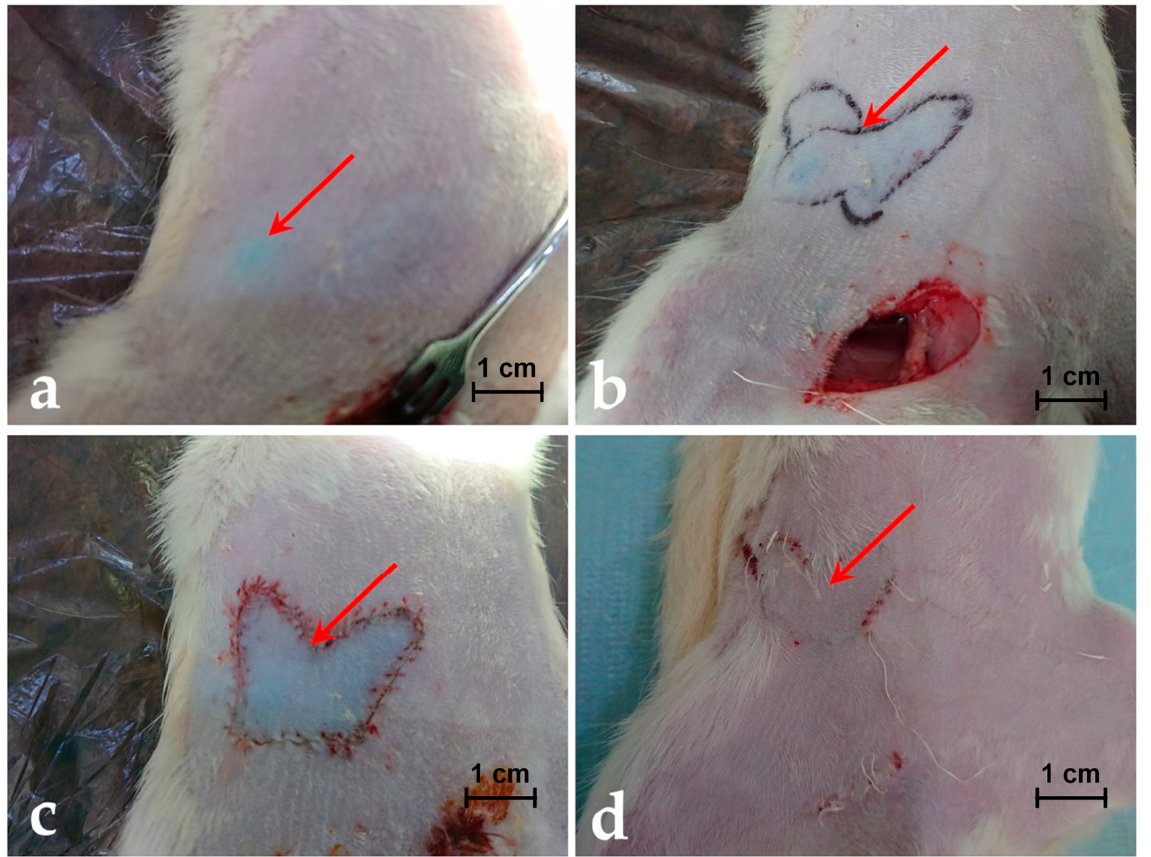
Figure 2. ( a ) Image of the skin coloured with MB in the place where the functional perforasome is highlighted. ( b ) Image with the margins/edges of the perforasome marked for better view. ( c ) Image with the perforator island flap rosed and sutured in site. ( d ) The perforator island flap at 14 days after the operative procedure.